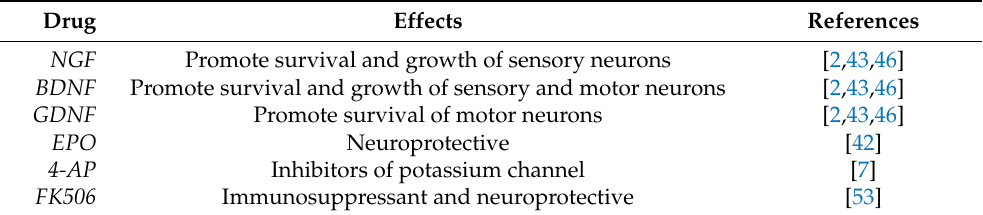
Table 1. A schematic list of drugs that promote nerve regeneration. Drug